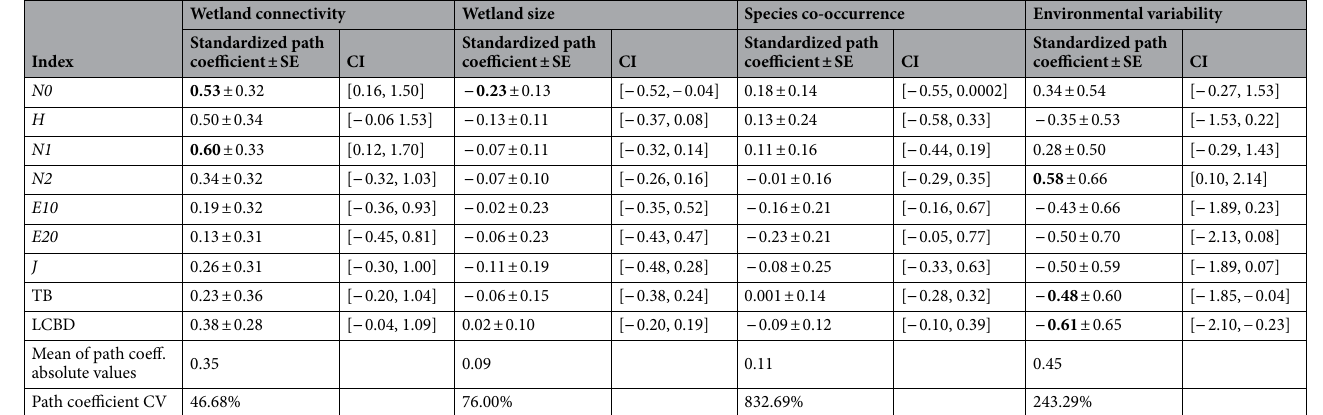
Table 2. Influence of wetland connectivity and size, species co-occurrence and environmental variability on each plant community parameter estimated by partial least squares structural equation modeling. The confidence intervals and significance of path coefficients of each ecological factor were evaluated based on 10,000 bootstrapping iterations. Significant path coefficients are in bold. Models were carried out separately for each community metric. N0 : Richness; H : Shannon entropy; N1 : Shannon diversity; N2 : Simpson diversity; E10 : Shannon evenness; E20 : Simpson evenness; J : Pielou’s evenness, TB: Total biomass and LCBD: